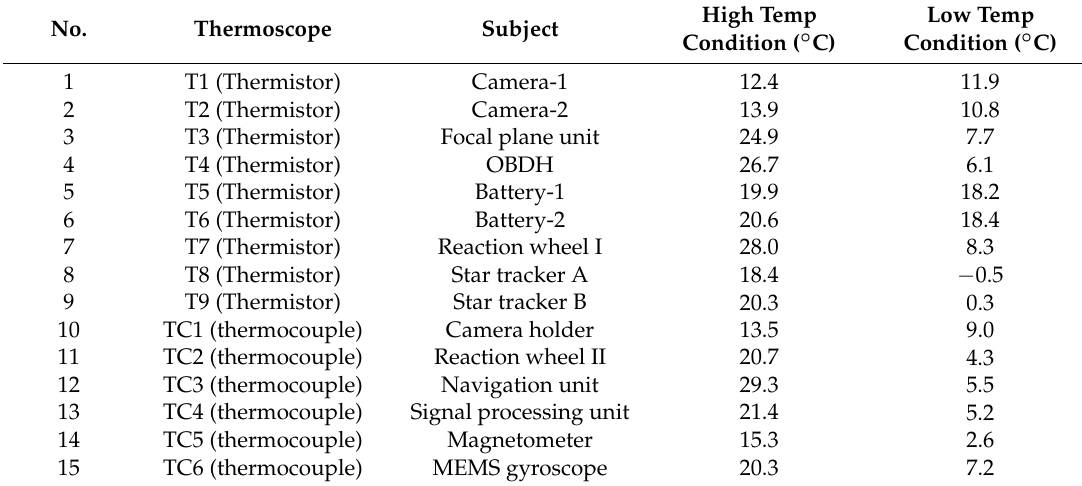
Table 13. Temperatures of the onboard instruments in thermal balance test.